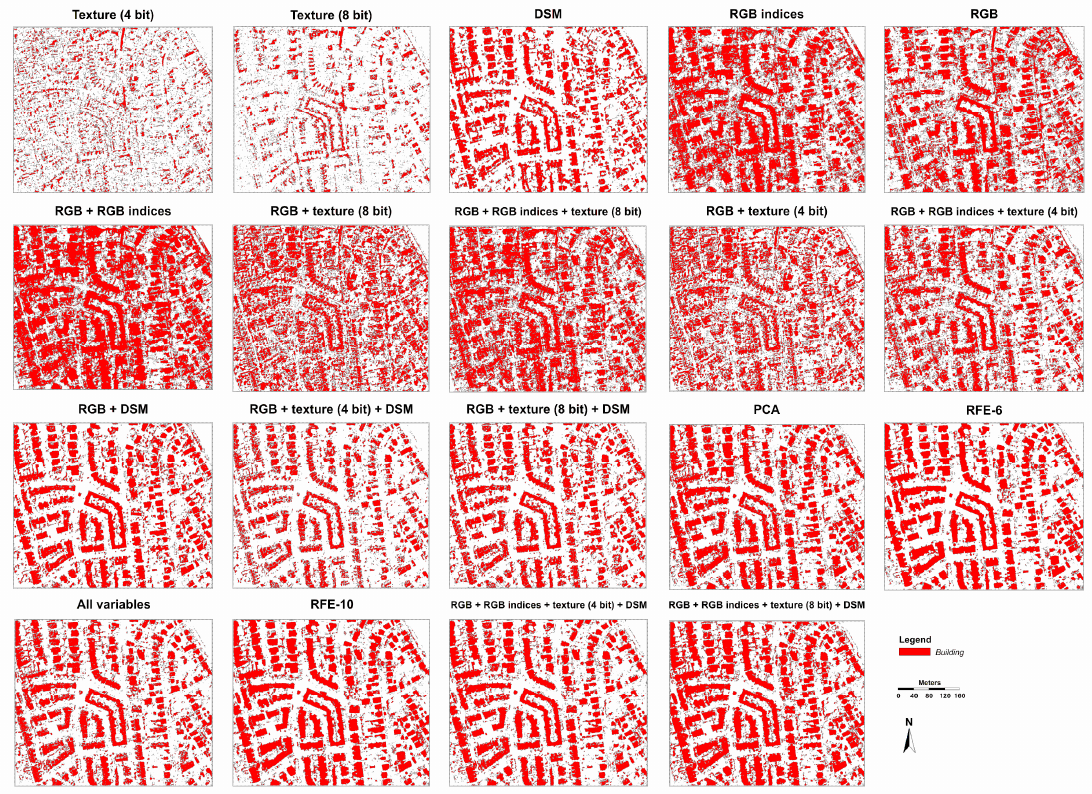
Figure 9. Building representations in the study area using different variable sets and random forest classifier (input variables: RGB: visible bands; RGB indices, texture: texture information, PCA: principal component analysis, DSM: DSM derivatives as morphometric indices, RFE: selected variables with recursive feature elimination).